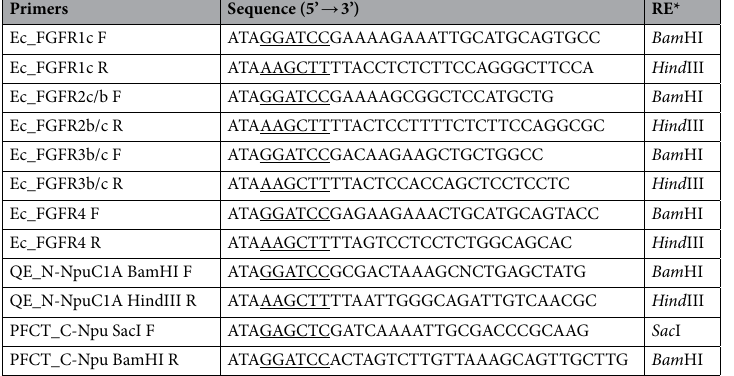
Table 1. List of primers used in this study. The target sequences incorporated in the primer for digestion with restriction enzymes have been underlined. *Restriction enzyme used to digest the amplified DNA fragment by PCR with a set of specific